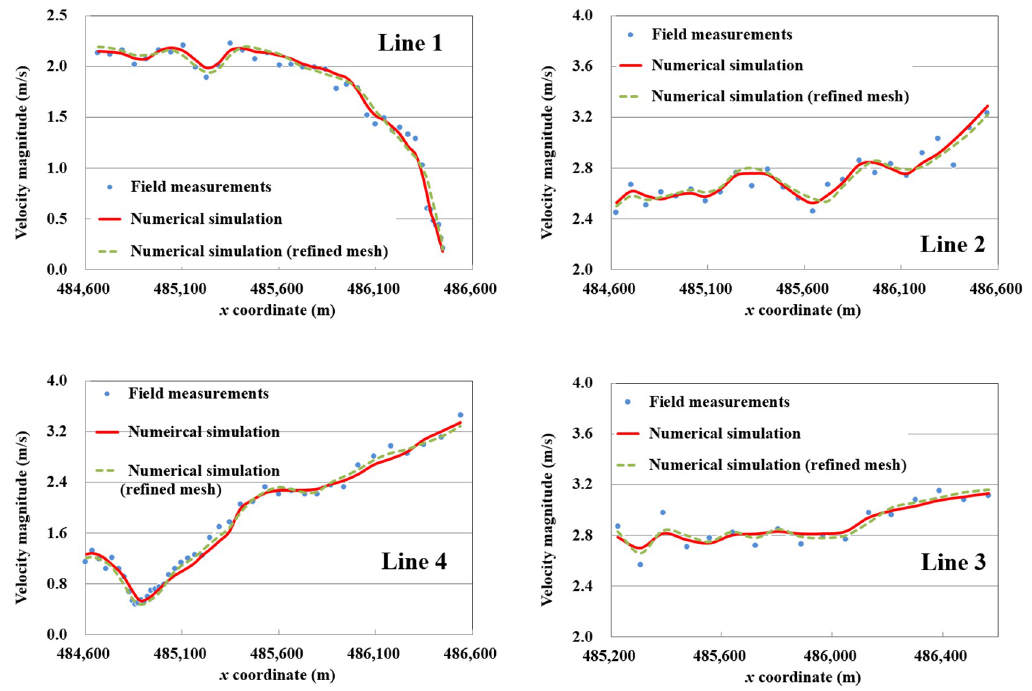
Figure 7. Comparison on the flow surface velocity in Case No.1. Table 2. Comparison on the water elevations in Case No.1.